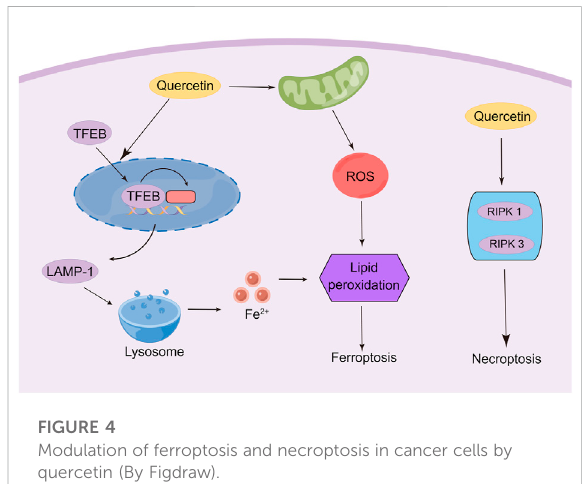
FIGURE 4 Modulation of ferroptosis and necroptosis in cancer cells by quercetin (By